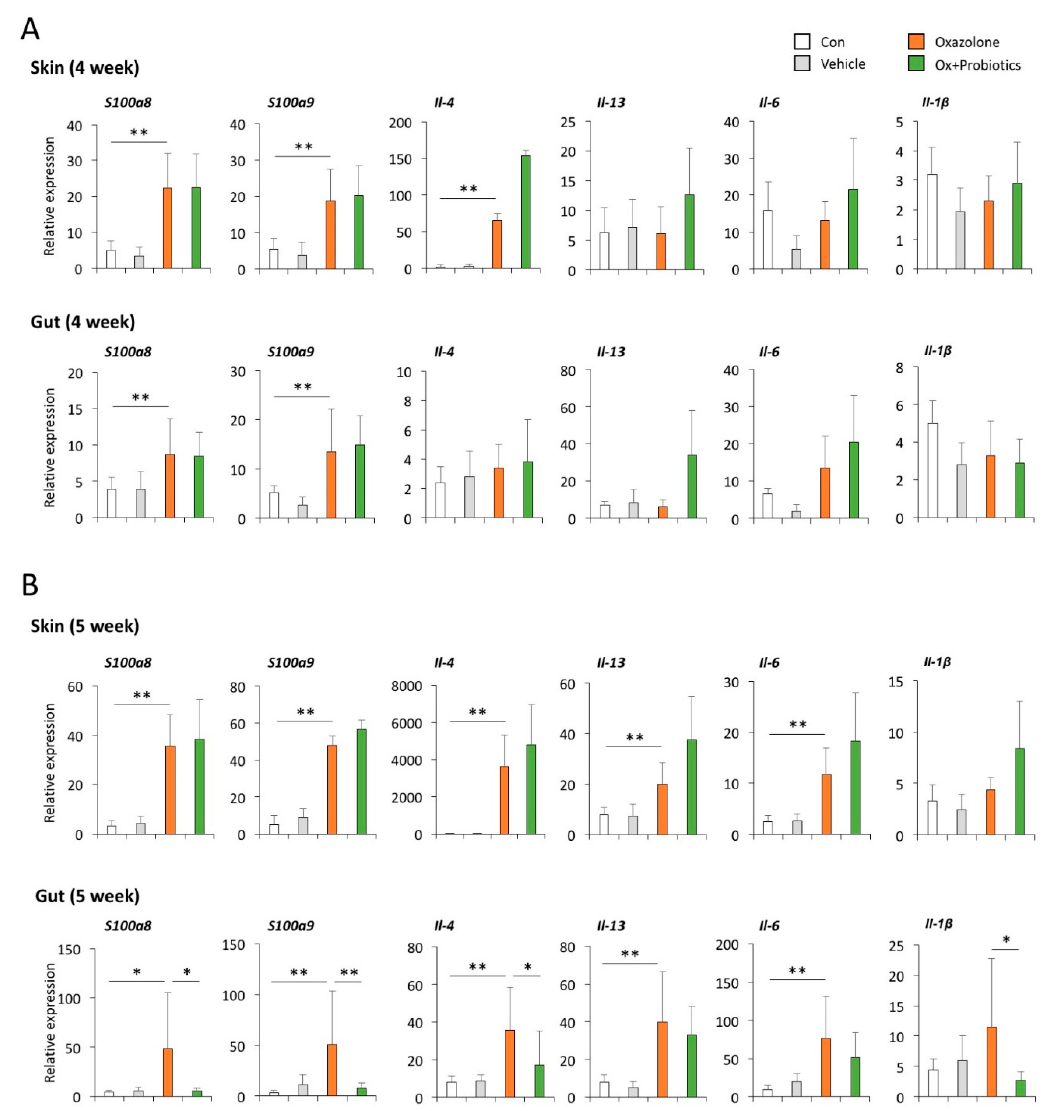
Figure 6. E ff ects of probiotics on the temporal expression of inflammatory cytokines and calprotectin in the skin and guts of Ox-induced AD mice. ( A ) Transcript levels of calprotectin ( S100a8 and S100a9 ) and inflammatory cytokines in the skin and guts of AD mice treated with probiotics for 1 week (from Week 3 to 4) in parallel with the sensitization with 0.1% Ox. Bars indicate the means ± SD. * p < 0.05, ** p < 0.01. ( B ) Transcript levels of calprotectin and inflammatory cytokines in the skin and guts of AD mice treated with probiotics for 2 weeks (from Week 3 to 5) in parallel with the sensitization with 0.1% Ox. Data pooled from two independent experiments are presented as the mean ± SD. * p < 0.05, ** p <